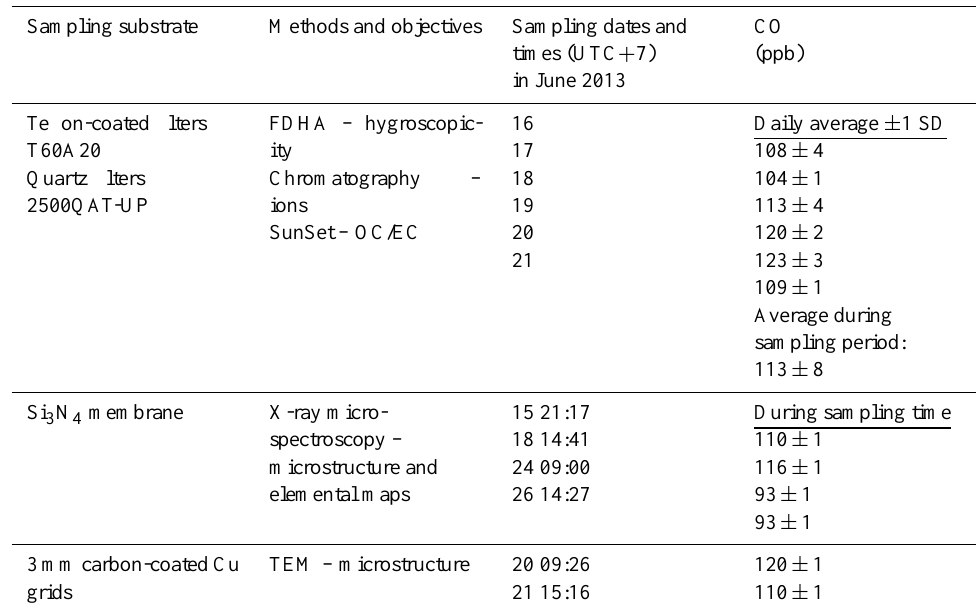
Table 1. CO mixing ratios (ppb) during the sampling periods on the different substrates. Sampling substrate Methods and objectives Sampling dates